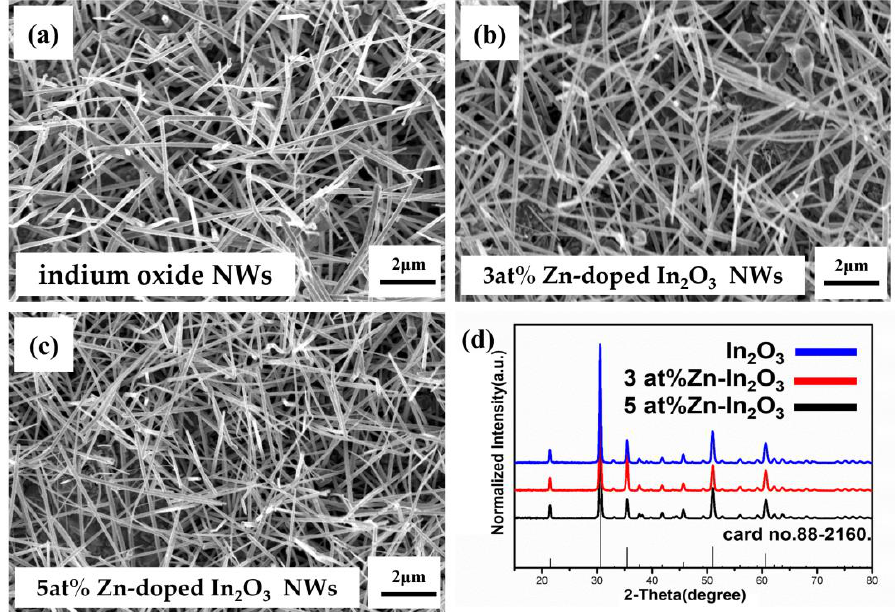
Figure 4. ( a – c ) SEM images of: ( a ) indium oxide nanowires; ( b ) 3 at% zinc-doped indium oxide nanowires; and ( c ) 5 at% zinc-doped indium oxide nanowires. ( d ) XRD analysis of In 2 O 3 , 3 at% Zn-In 2 O 3 , and 5 at% Zn-In 2 O 3 nanowires.